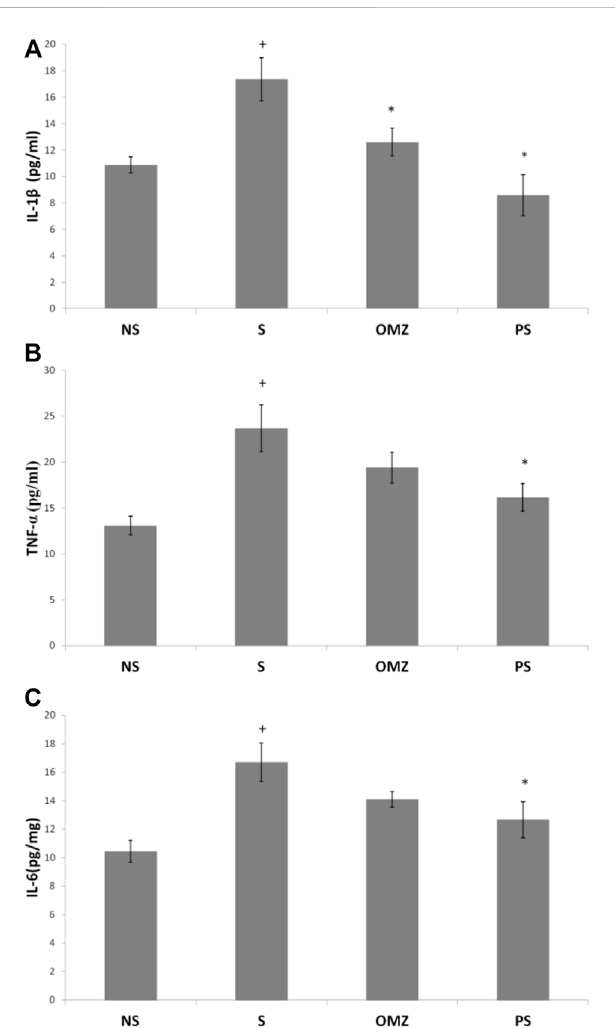
FIGURE 5 Effects of P. sarmentosum (500 mg/kg; PS) and omeprazole (20 mg/kg; OMZ) on gastric (A) TNF- α , (B) IL-1 β , and (C) IL-6 protein levels in rats exposed to WIRS for 3.5 h. Bars represent mean ± SEM ( n = 7).Key:+, p < .05comparedtothenon-stress(NS)controlgroup;*, p < .05 compared to the stress (S) control group; #, p < .05 compared